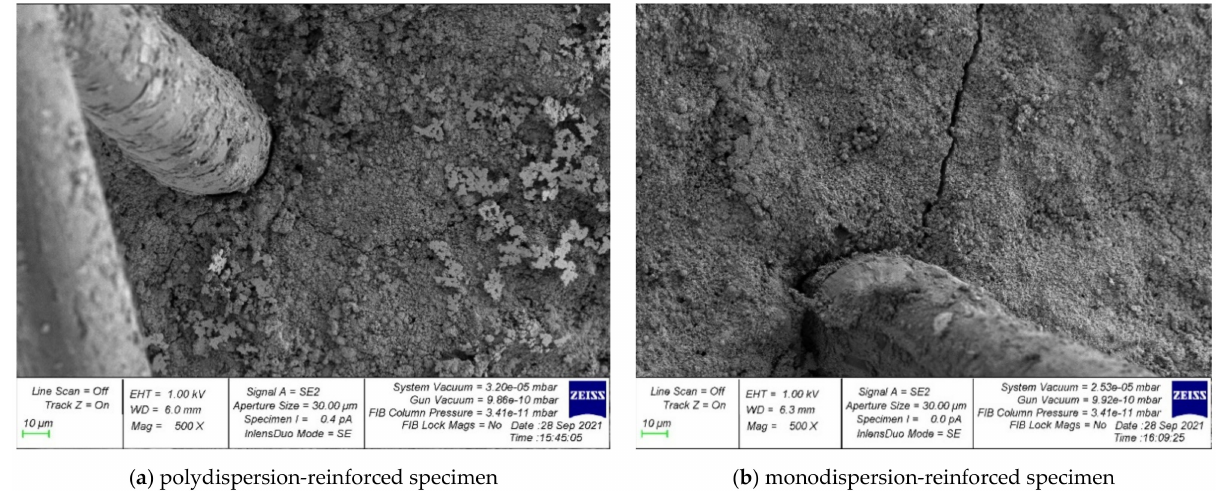
Figure 7. Crack formation in the “fiber-contact zone–cement matrix” system.